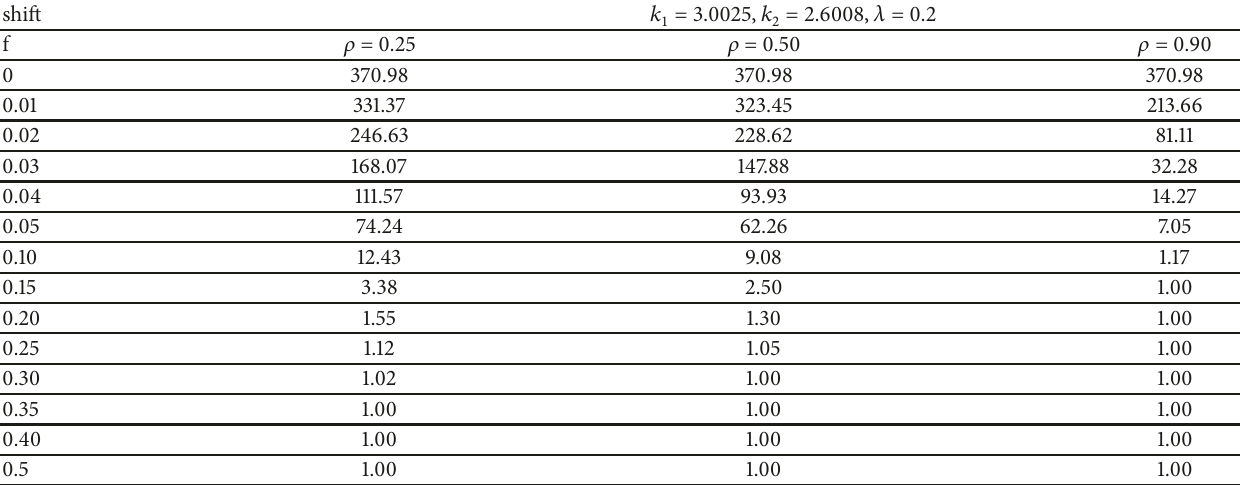
Table 11: ARLs for proposed repetitive EWMA-RSS control chart using Khan et al. [8] exponential ratio-type estimator, when 𝑟 𝑜 is 370.